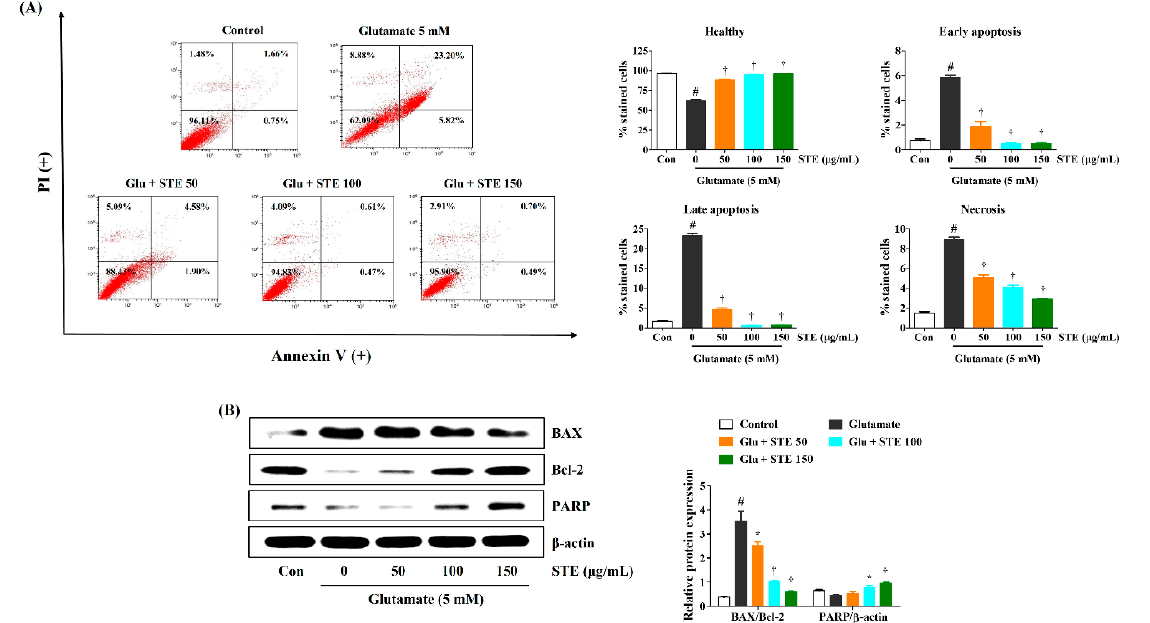
Figure 3. Effects of Selaginella tamariscina ethanol extract (STE) against glutamate-induced apoptosis in HT22 cells. Cells were pretreated with STE concentrations of 50, 100, or 150 μ g/mL and then exposed to glutamate (5 mM). ( A ) Apoptosis of HT22 cells was evaluated via flow cytometry. Quantitative data showed the percentage of healthy, early apoptotic, late apoptotic, and necrotic cells according to treatment. ( B ) The expression levels of Bcl-2-associated X, B-cell lymphoma 2, and Poly (ADP-ribose) polymerase were determined via Western blot analysis. Control cells were incubated with the vehicle alone. Blot images represent three independent experiments. Data are presented as mean ± standard error of the mean. PI, propidium iodide; Glu, glutamate; Con, control; BAX, Bcl-2-associated X; Bcl-2, B-cell lymphoma 2; PARP, Poly (ADP-ribose) polymerase. Statistical significance was defined as # p < 0.05 (vs. control), * p < 0.05, and † p < 0.001 (vs.